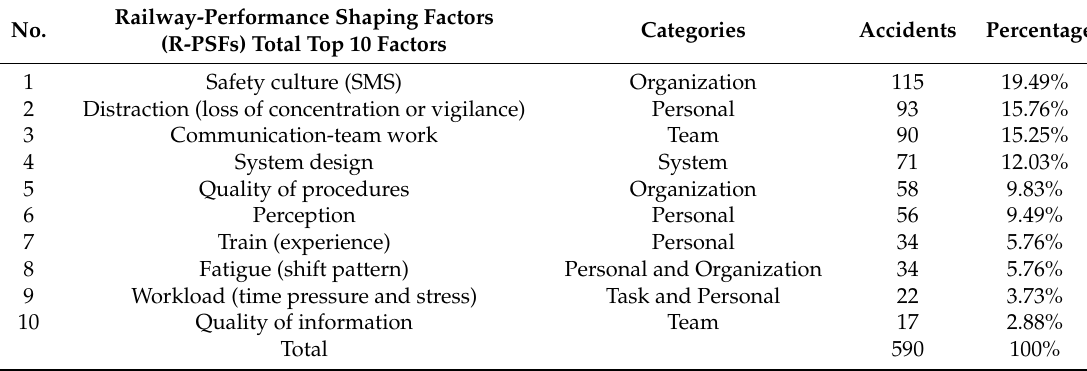
Table 3. Railway-Performance Shaping Factors (R-PSFs) of train safety in the accident